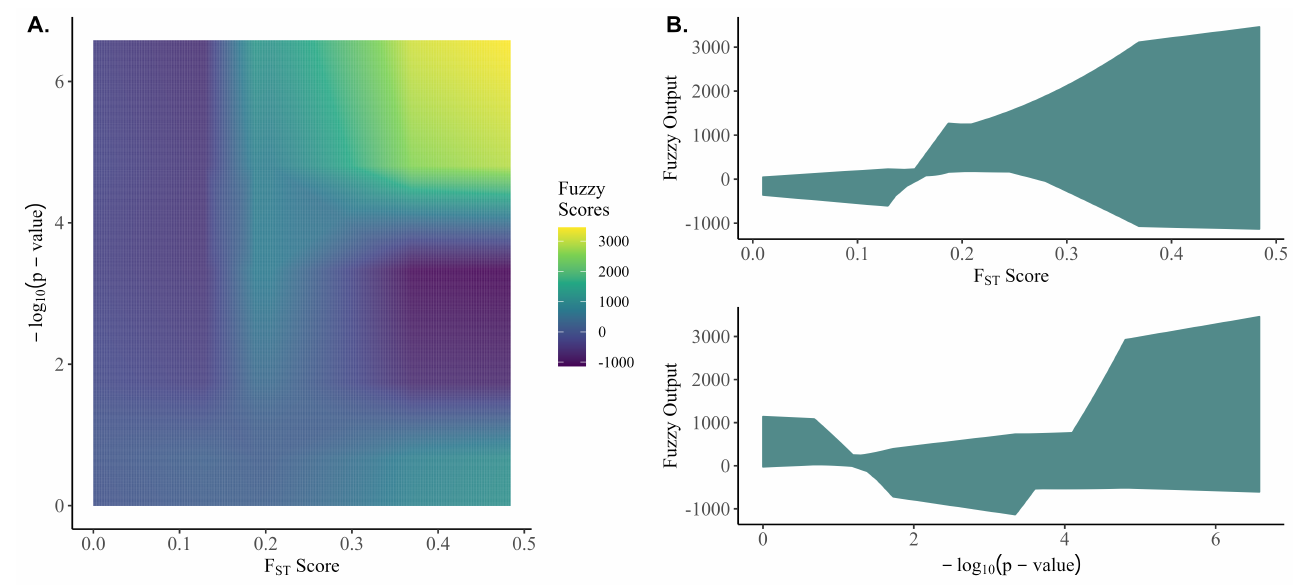
Figure 2. The fuzzy output space for the observed range of F ST scores and − log 1 0 ( p -value). p -values were calculated jointly using a single-step genome-wide association study approach with the BLUPF90 suite of programs, as described in [24], where genomic predic- tions are first calculated using a single-step GBLUP (ssGBLUP) model and SNP effects are then jointly calculated from the genomic